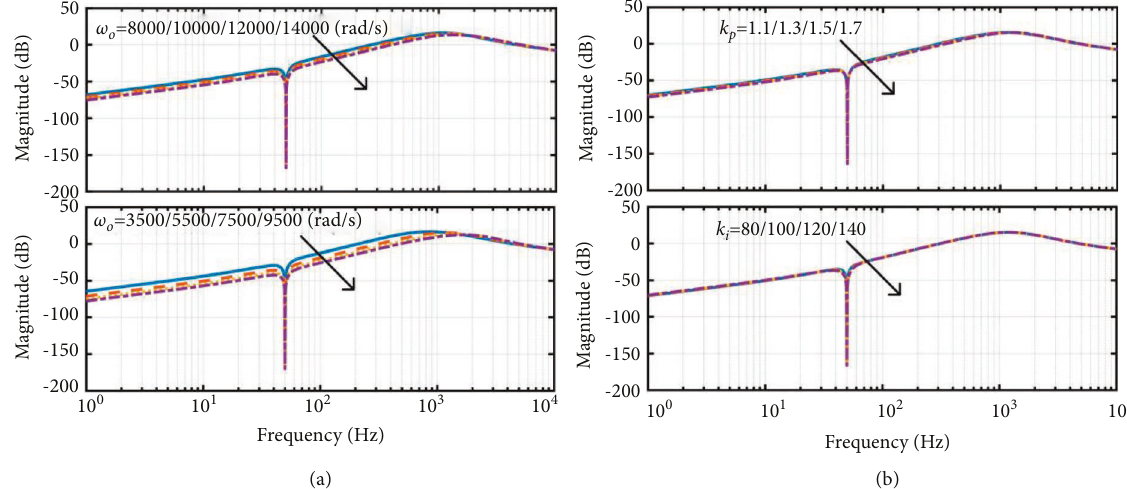
� 100, and k � 1.5). p